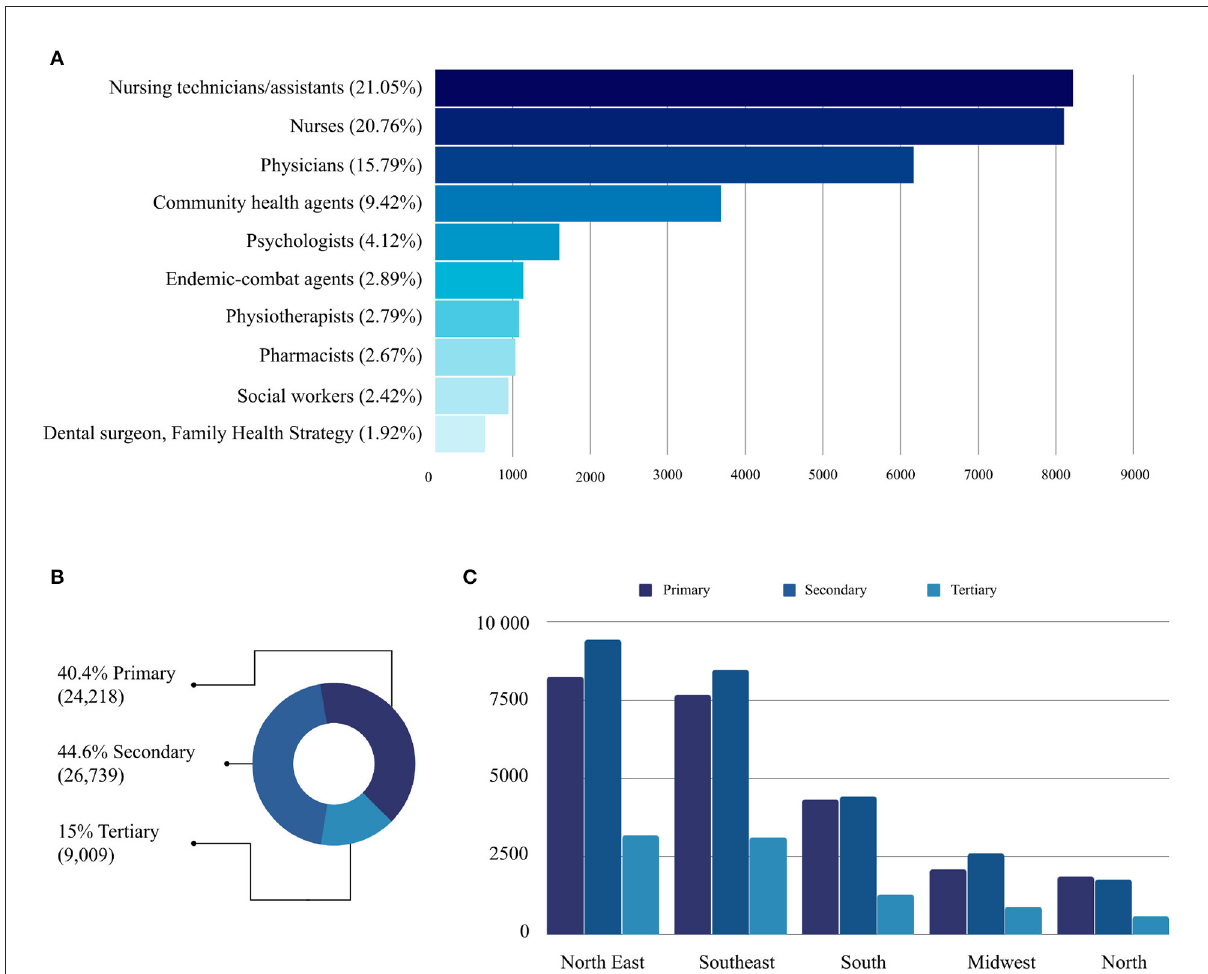
Figure 10 evidences a negative Spearman’s correlation